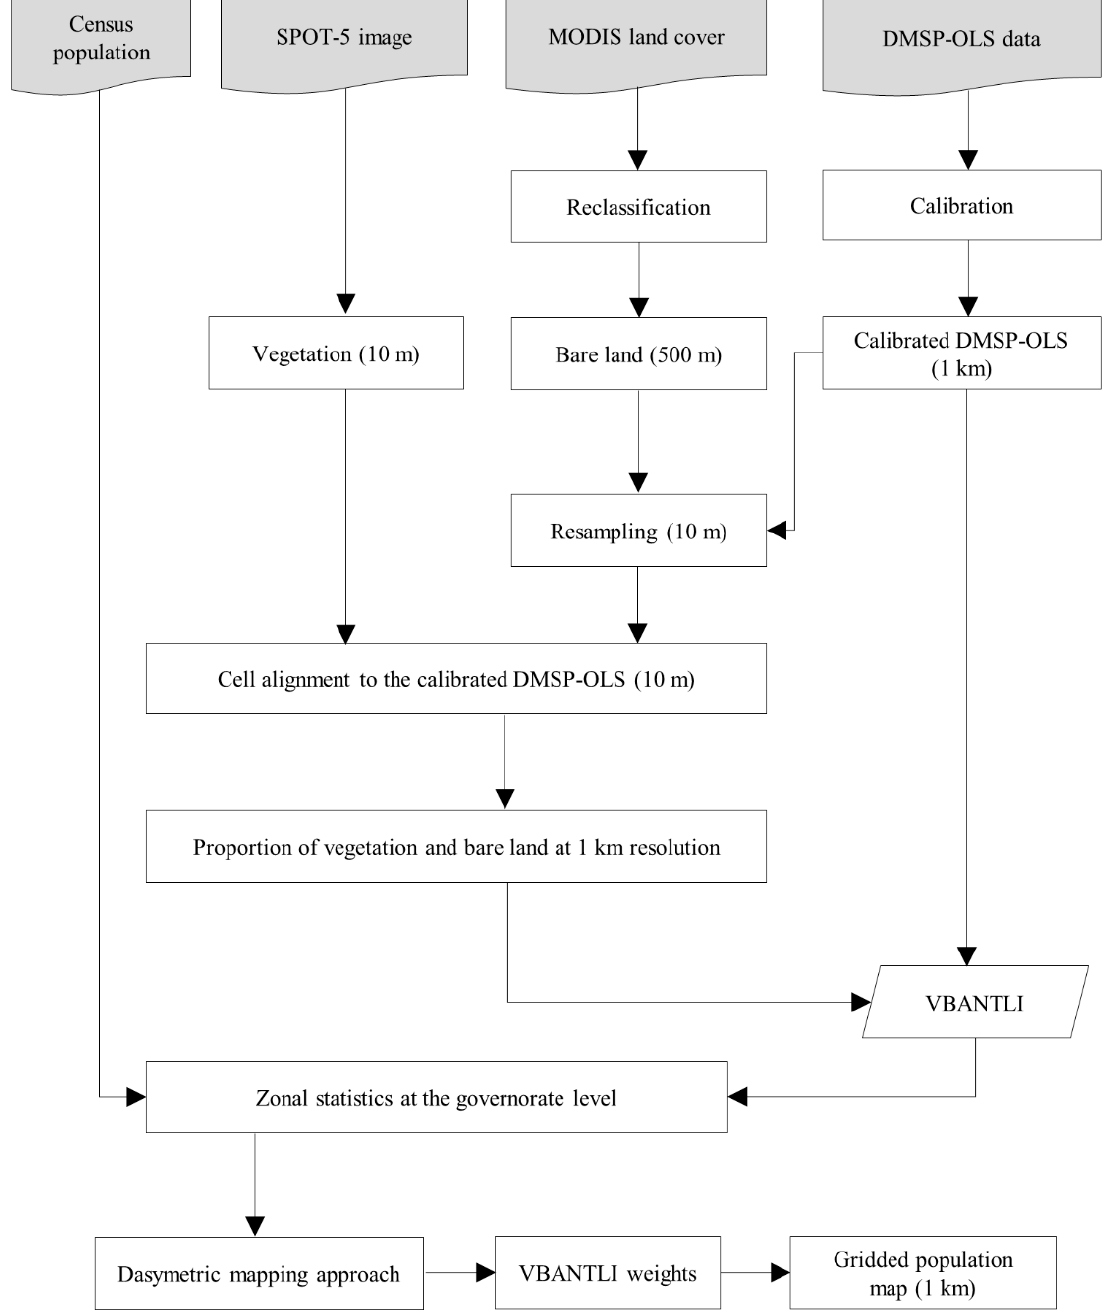
Figure 3. Flowchart of the methodology for downscaling the census population data.